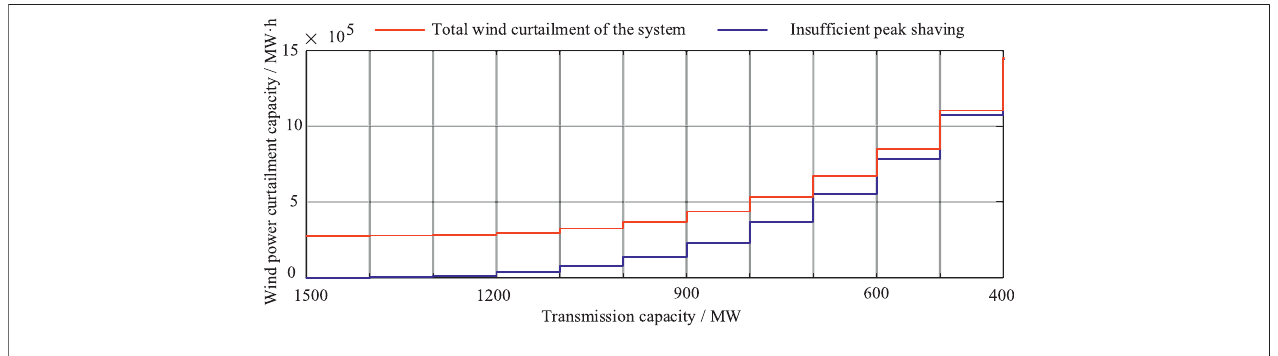
FIGURE 6 | Wind farm cluster centralized